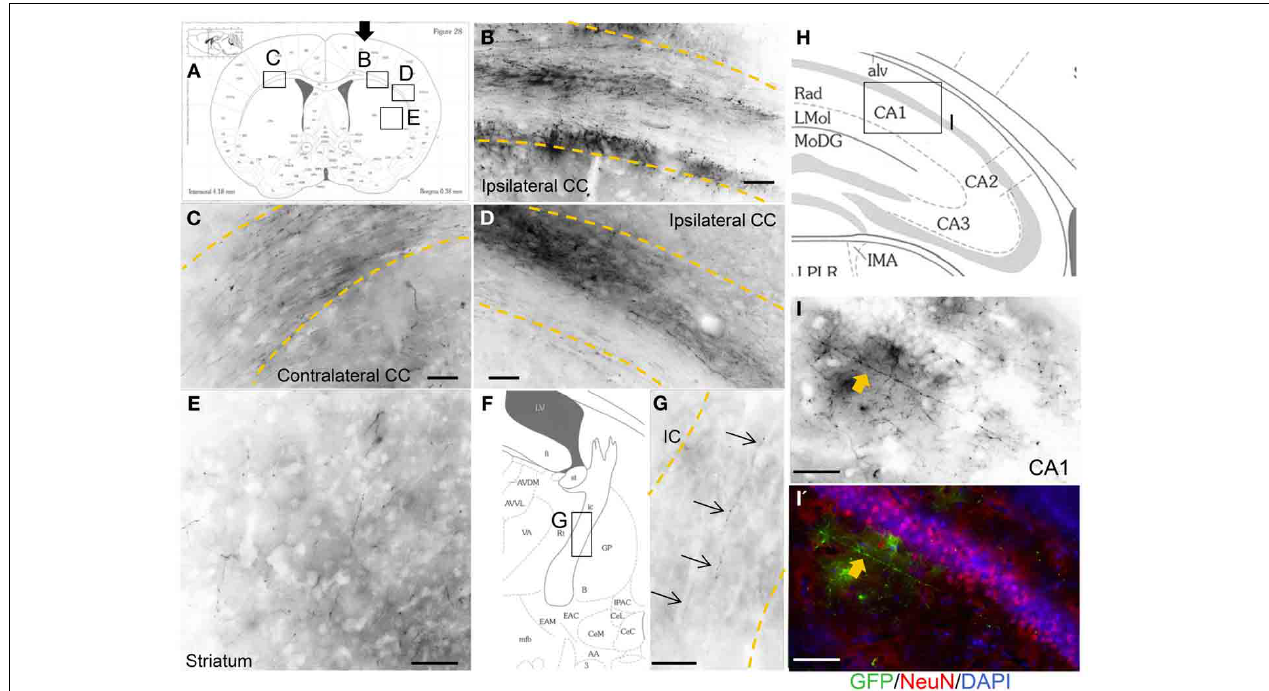
FIGURE 5 | Axonal outgrowthfrom the motor cortex transplant. Schematic representations determined from the mouse brain of each photograph (Franklin and Paxinos, 2008), (A) coronal section, (F) magnified coronal section centering around the internal capsule, and (H) magnified coronal section centering around the hippocampus. Black arrow in (A) shows